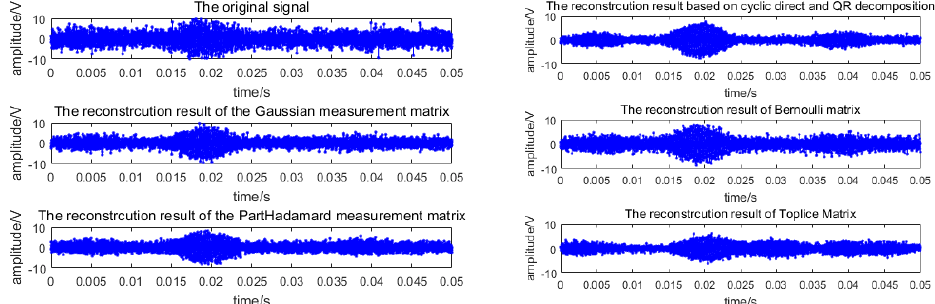
Figure 4. Reconstruction results by different types of measurement matrices (SNR = − 3 dB).